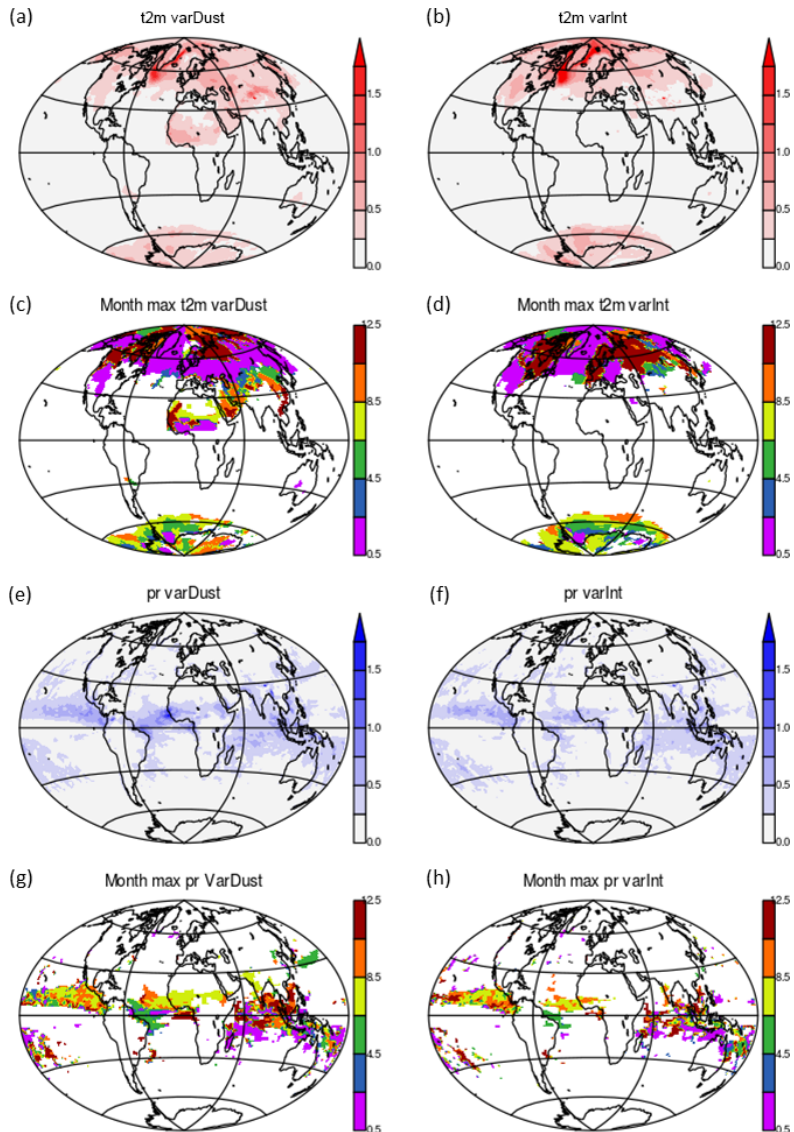
Figure 8. Identification of the regions where differences are maximum between (a, c, e, g) the mid-Holocene dust sensitivity experiments compared to (b, d, f, h) regions where centennial variability is maximum. Panels (a) , (b) , (c) and (d) provide the results for 2m air temperature and (e) , (f) , (g) and (h) for precipitation. The different analyses correspond to (a, e) mean root mean square differences between the four mid-Holocene simulations with different dust forcing, (b, f) mean root mean square differences between non-overlapping 100-year periods of the reference mid-Holocene simulation MHREF and (a, b, g, f) months for which the root mean squares for the different analyses is maximum. 2m air temperature is expressed in ◦ C and precipitation in mmd − 1